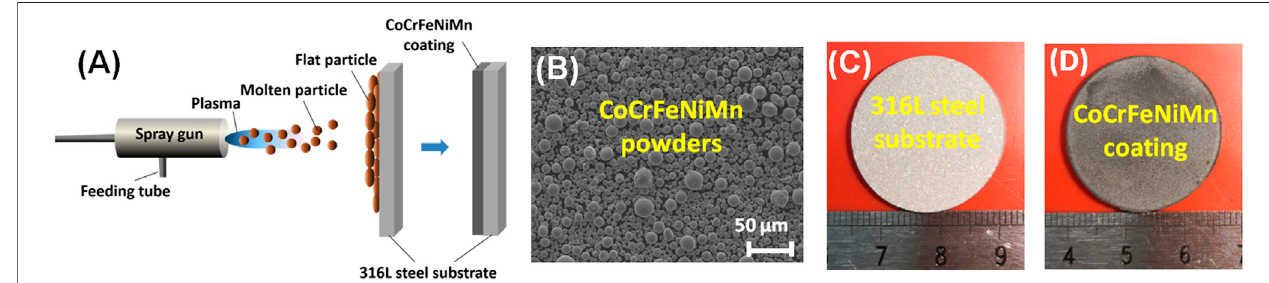
FIGURE 1 | The whole procedure of preparation of CoCrFeNiMn HEA coatings by APS. (A) Schematic diagram of APS technique; (B) SEM morphology of the CoCrFeNiMn powders; (C) 316L steel substrate after sandblasting; (D) the macro morphology of CoCrFeNiMn HEA coatings prepared by APS.